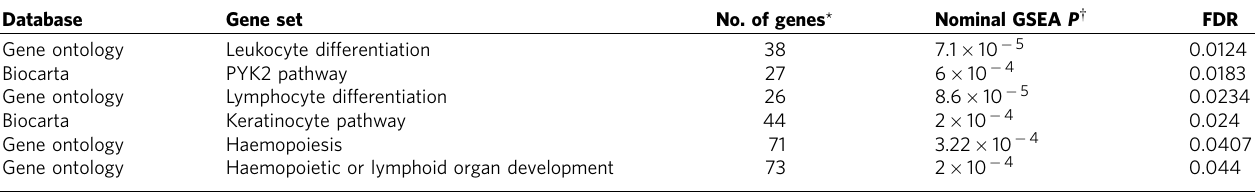
Table 1 | GSEA results for ICA2 pattern.